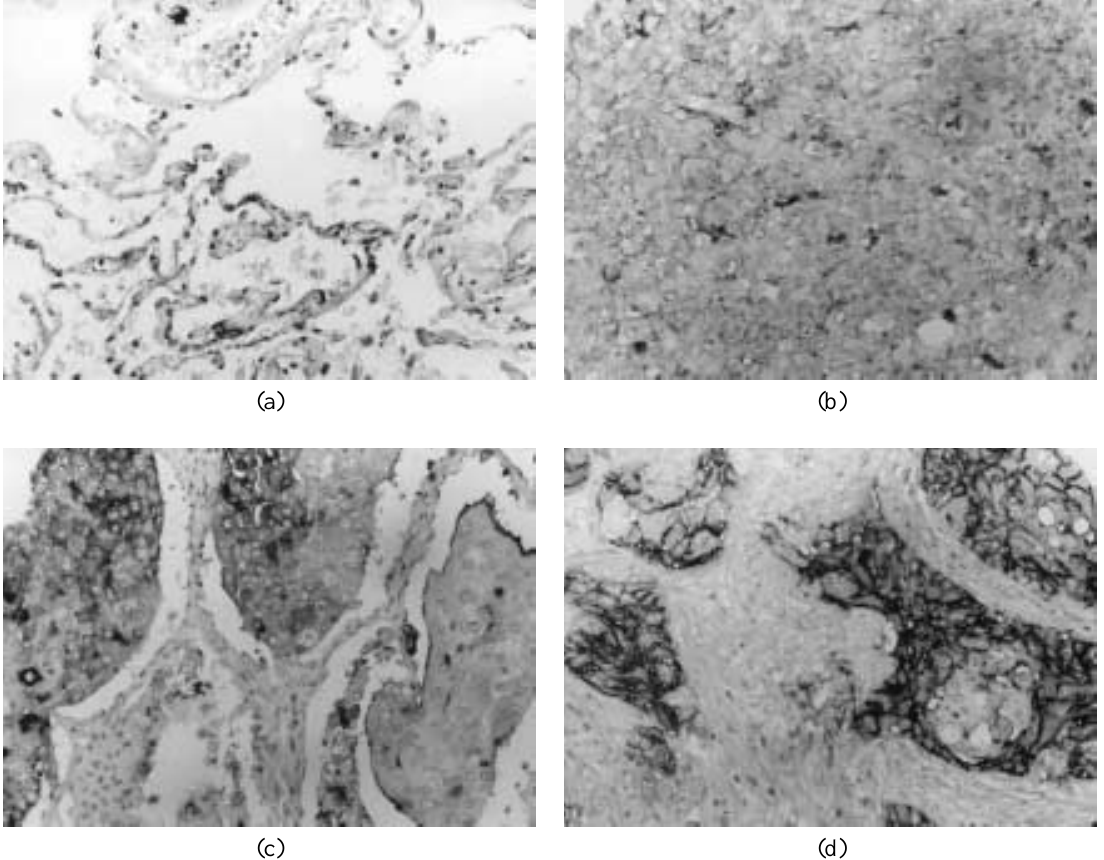
Fig. 1. CD10 Immunohistochemistry in NSCLC. (a) Normal lung parenchyma with CD10 expression in alveolar capillaries, (b) adenocarcinoma with weak CD10 expression (1 + ), (c) adenocarcinoma and (d) squamous cell carcinoma with strong CD10 expression (2 +